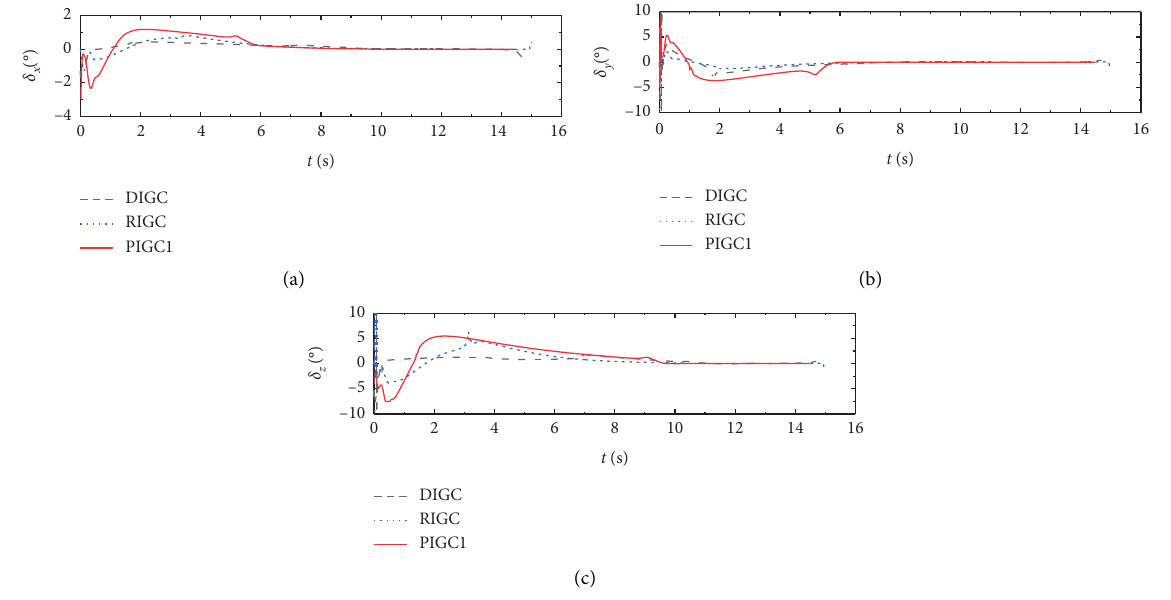
Figure 11: Curves representing rudder deflection angles of Case 2.